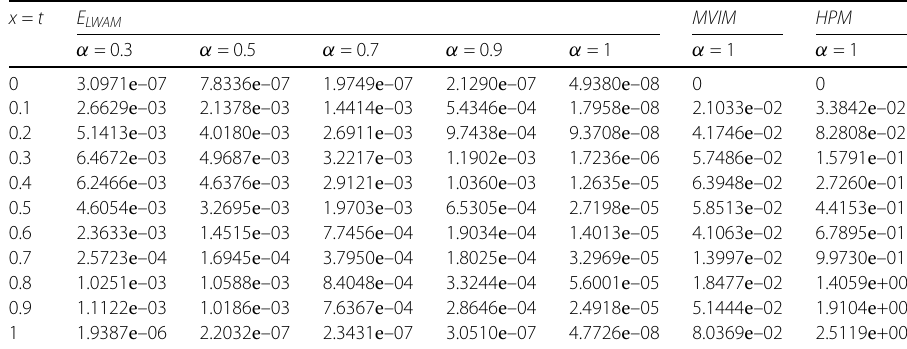
Table 3 Absolute errors for N = 6, k = 3, M = 5, when α goes to 1, and comparison with HPM [33] and MVIM [36] in Example 2